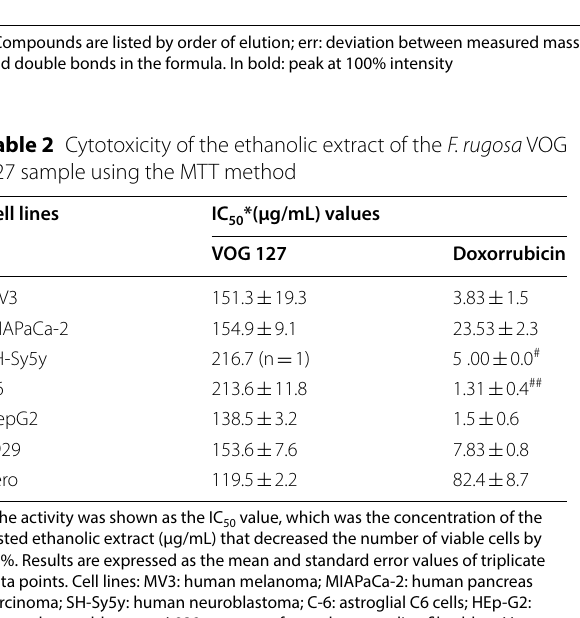
a Compounds are listed by order of elution; err: deviation between measured mass and theoretical mass of the respective compound in [ppm]; rdb: number of rings and double bonds in the formula. In bold: peak at 100% intensity